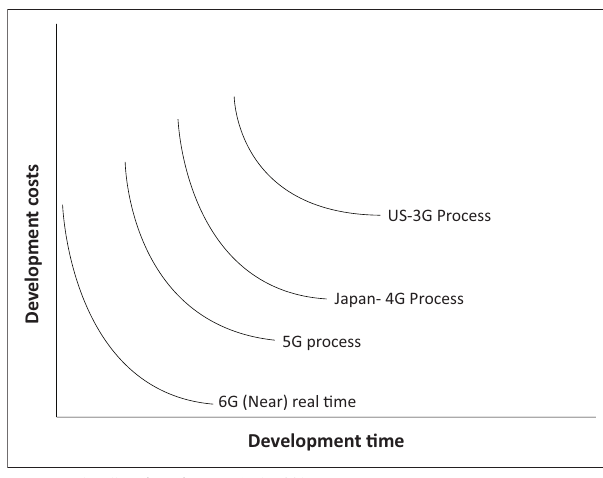
FIG URE 1: Rothwell’s generations of